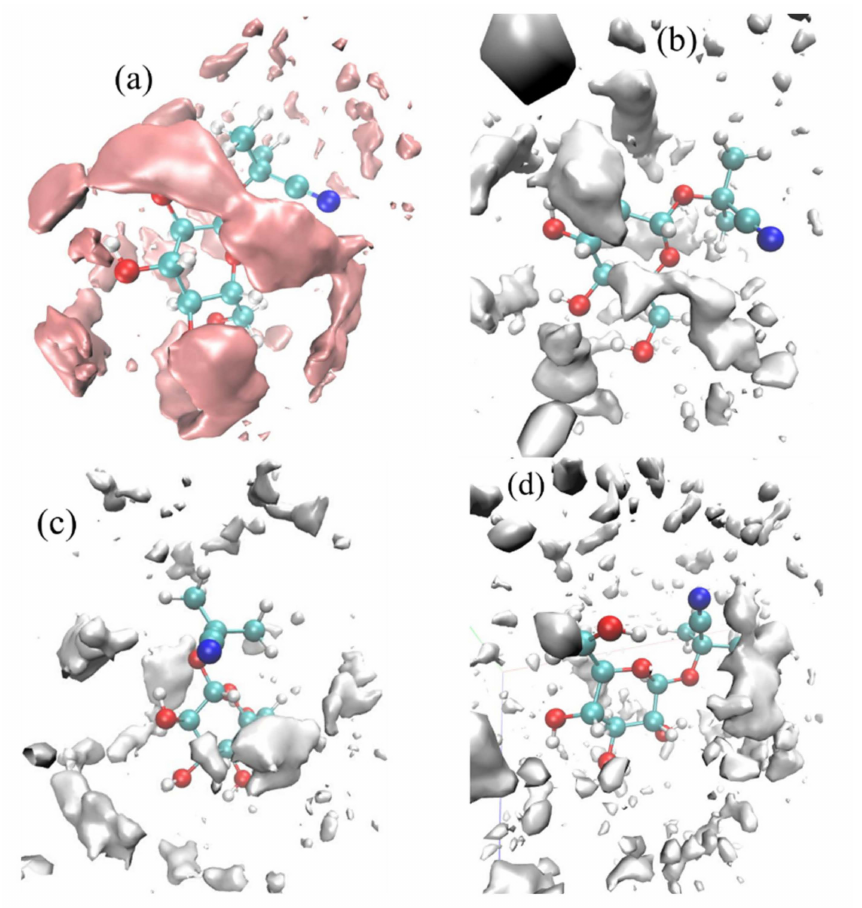
Figure 8. Spatial distribution function of solvents around a linamarin molecule in ( a ) water, ( b ) MeOH, ( c ) DMSO and ( d )